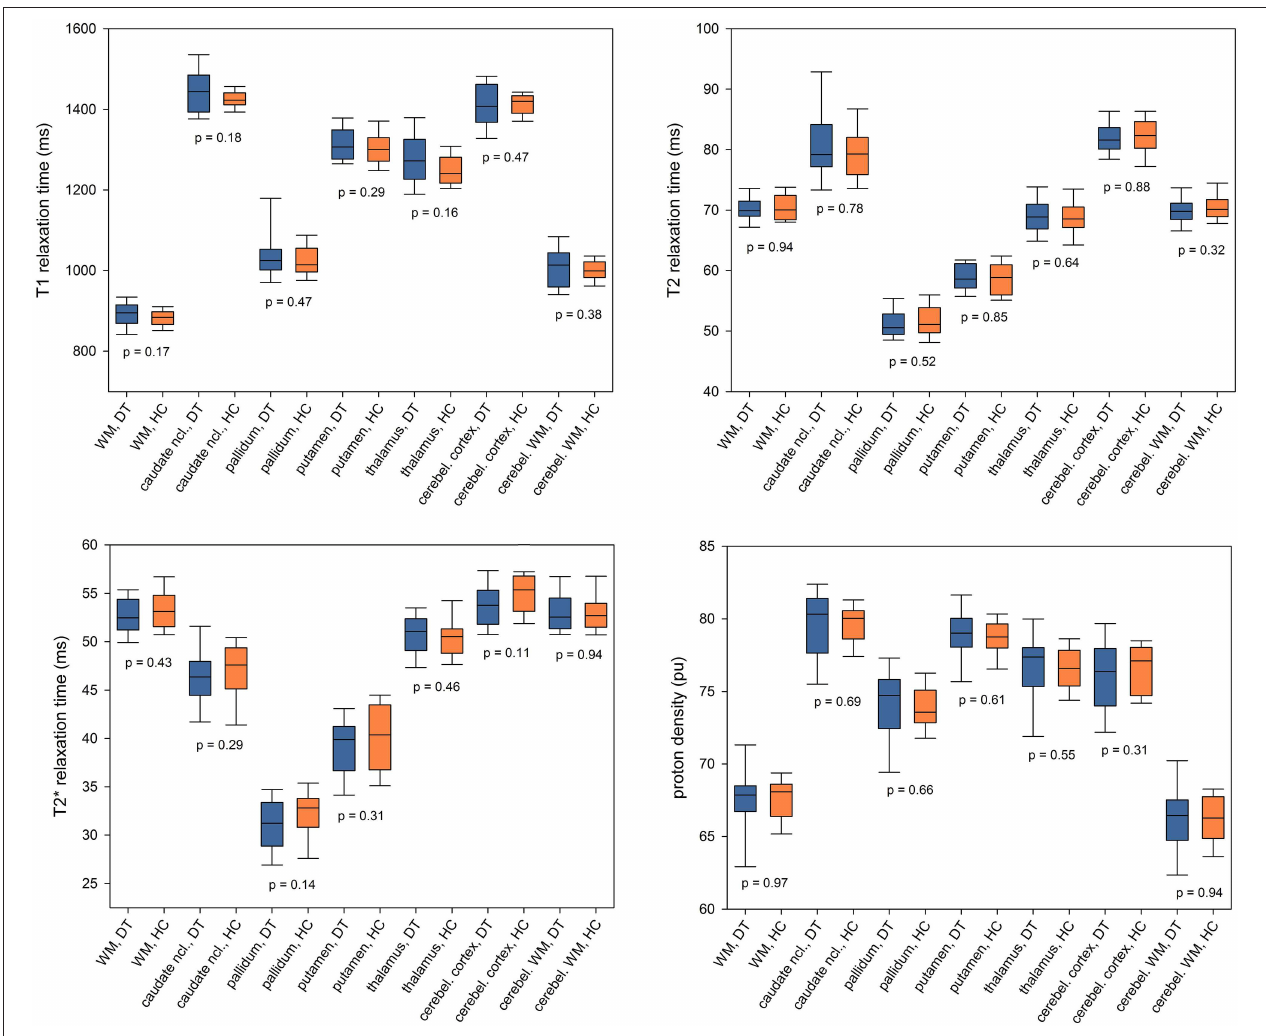
FIGURE 3 | Region of interest-based analysis of T 1 , T 2 , and T * 2 relaxation times and proton density. qMRI values were averaged across bilateral ROIs and presented as boxplots (median, upper, and lower quartile and 90% CI) for the patients with idiopathic cervical dystonia (DT) and healthy control subjects (HC). P -values for between-group comparisons are inserted into the diagram below the corresponding boxplots. Ncl., nucleus; cerebel.,